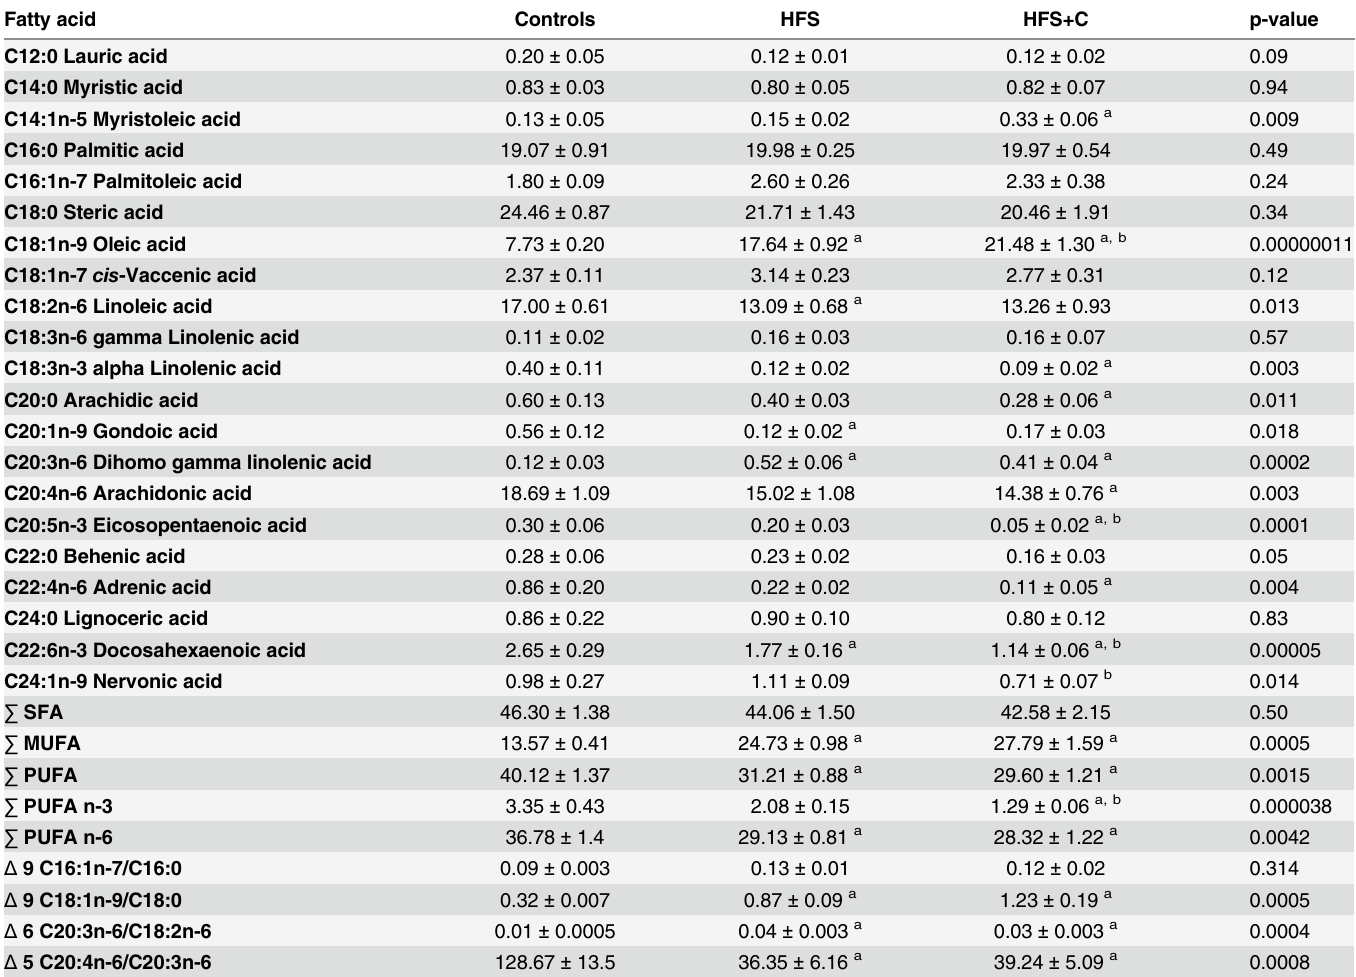
Table 4. Fatty acid composition of